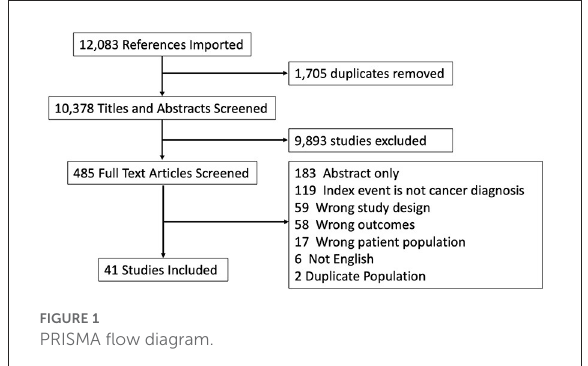
FIGURE1 PRISMA flow